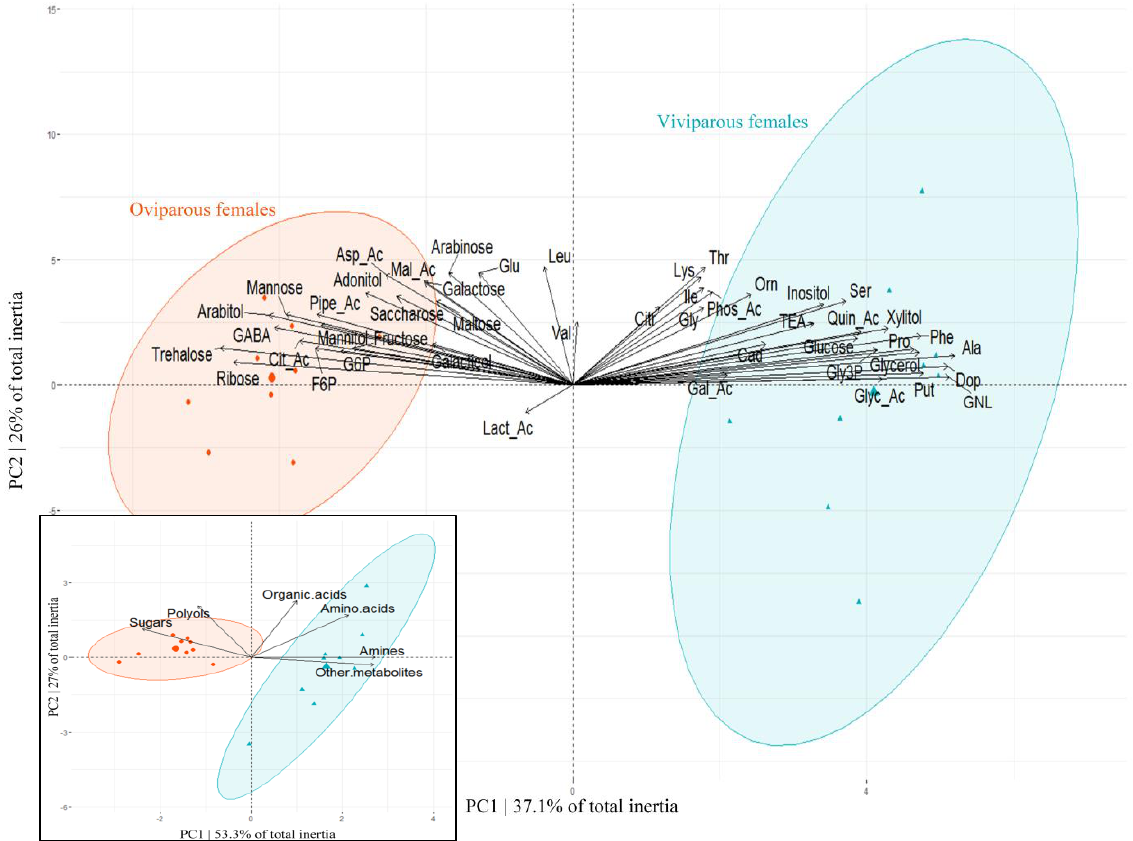
Figure 4 : Multivariate analysis (PCA) on the first two principal components (PC) representing links between metabolic compounds (47 log-transformed variables, nmol.mg -1 ) and two aphid morphs (oviparous vs . viviparous females) of Acyrthosiphon pisum . Enclosed figure in the upper panel shows a PCA of the six metabolite categories. Confidence ellipses (95%) are constructed around each aphid group centroid (n=9 replicates of 3 individual aphid each by morph). Contributions of metabolite variables to PC1 and PC2 are provided in supplementary figure S3. Abbreviations are Alanine (Ala), Aspartic acid (Asp_Ac), Cadaverine (Cad), Citric acid (Cit_Ac), Citrulline (Citr), Dopamine (Dop),